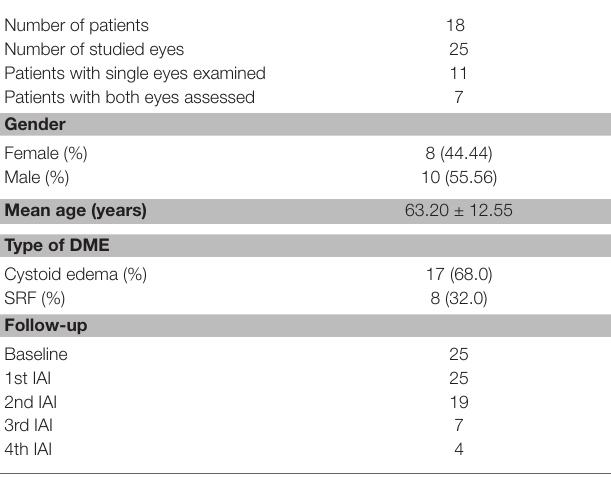
TABLE 2 | BCVA values before and after IAI in patients with